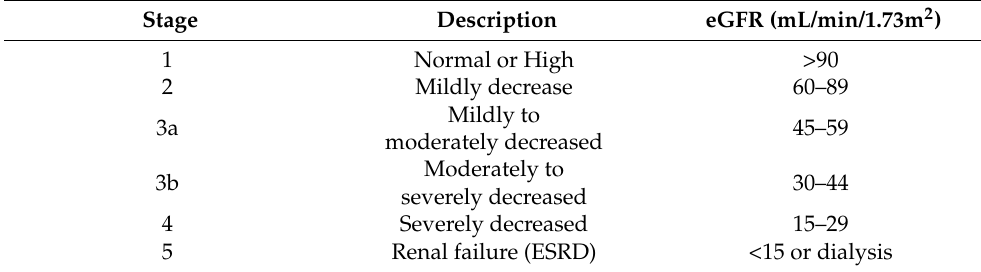
Figure 1. Prevalence of atrial fibrillation (AF) in chronic kidney disease (CKD) patients and vice versa. Similarly, AF coexists in up to 15–20% of CKD subjects, especially in end stage renal disease (ESRD) patients, who are identified on the basis of an estimated glomerular filtra- tion rate (eGFR) < 15 mL/min, including those requiring dialysis (Table 1) [2,13–16]. Table 1. Stages of CKD according to eGFR. CKD: chronic kidney disease; eGFR: estimated glomer- ular filtration rate; ESRD: end stage renal disease.